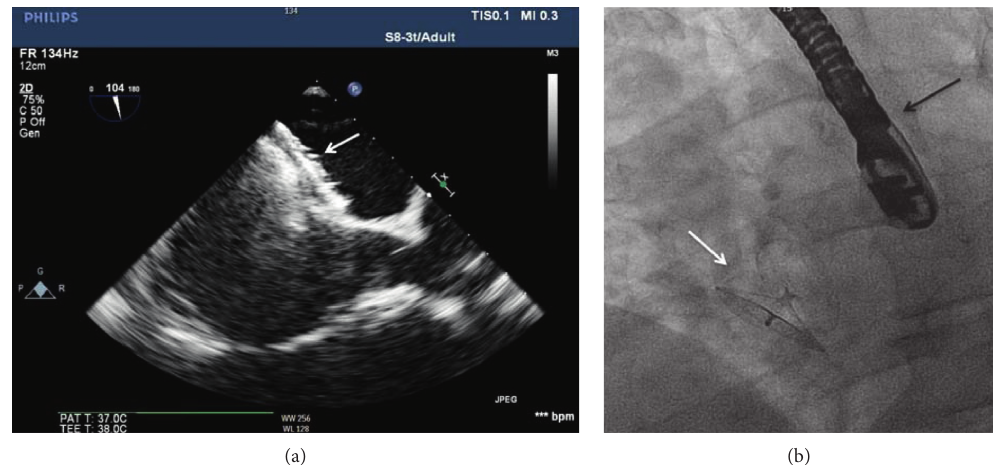
Figure 1: The Occlutech ASD device (white arrow) using the transesophageal echocardiography (TEE) probe (a) and fluoroscopy (b). The black arrow indicates the TEE probe during fluoroscopy.